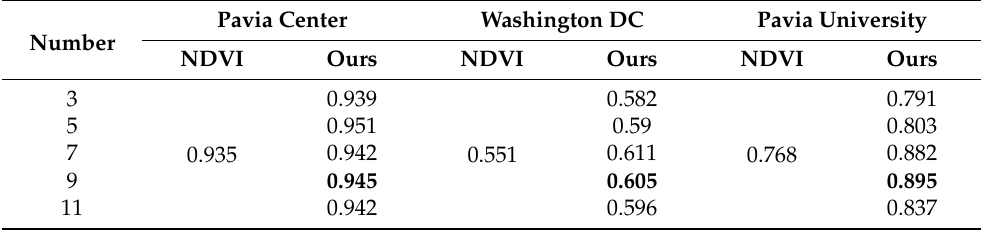
Table 14. The overall accuracy of vegetation extraction for the different number of bands. Number